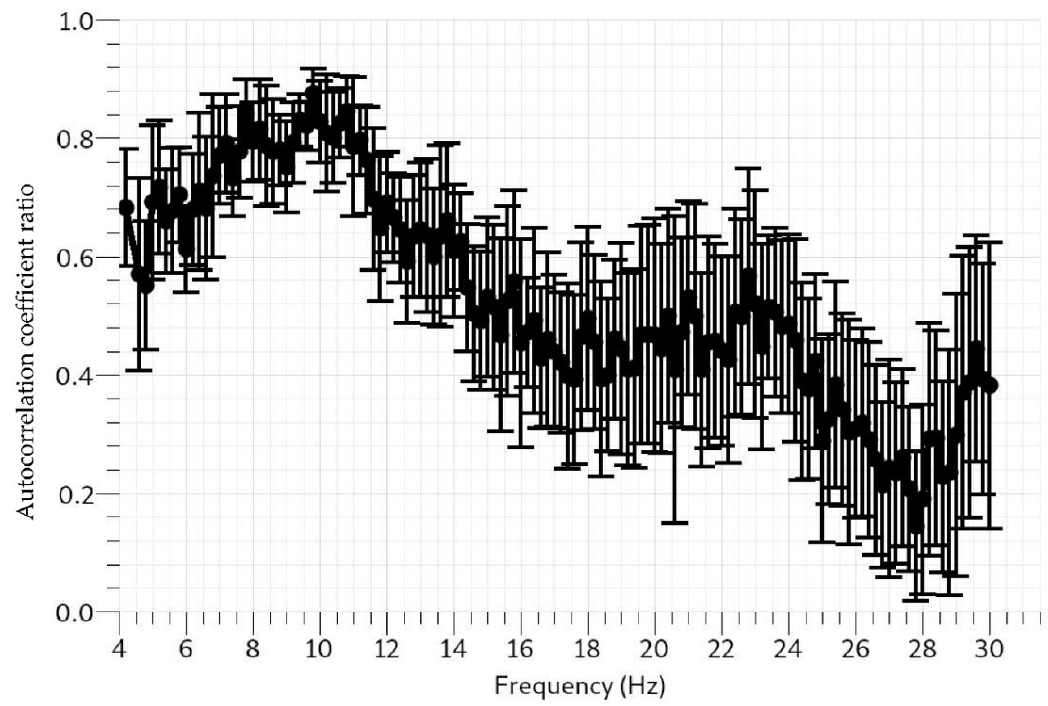
Figure 12. Spatial autocorrelation coefficient ratio vs. frequency plot shows the SPAC curve.